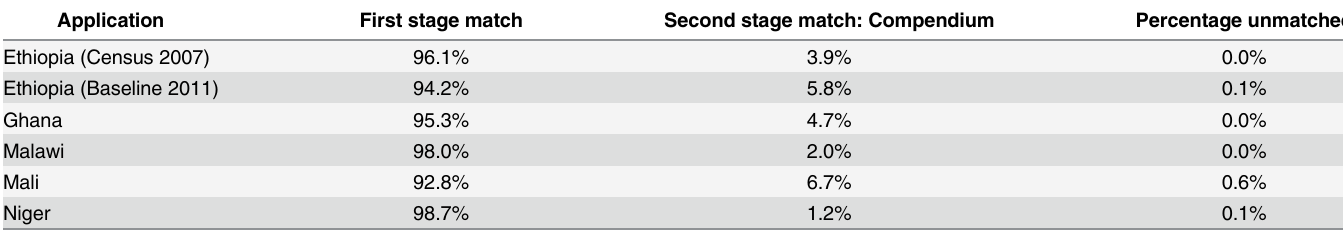
Table 4. Birth History Imputation Method: Proportions of Cases Matched.